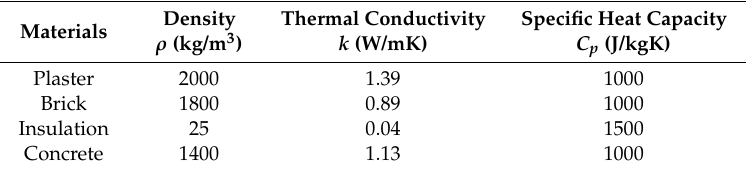
Table 2. Physical properties of building materials [23,25].